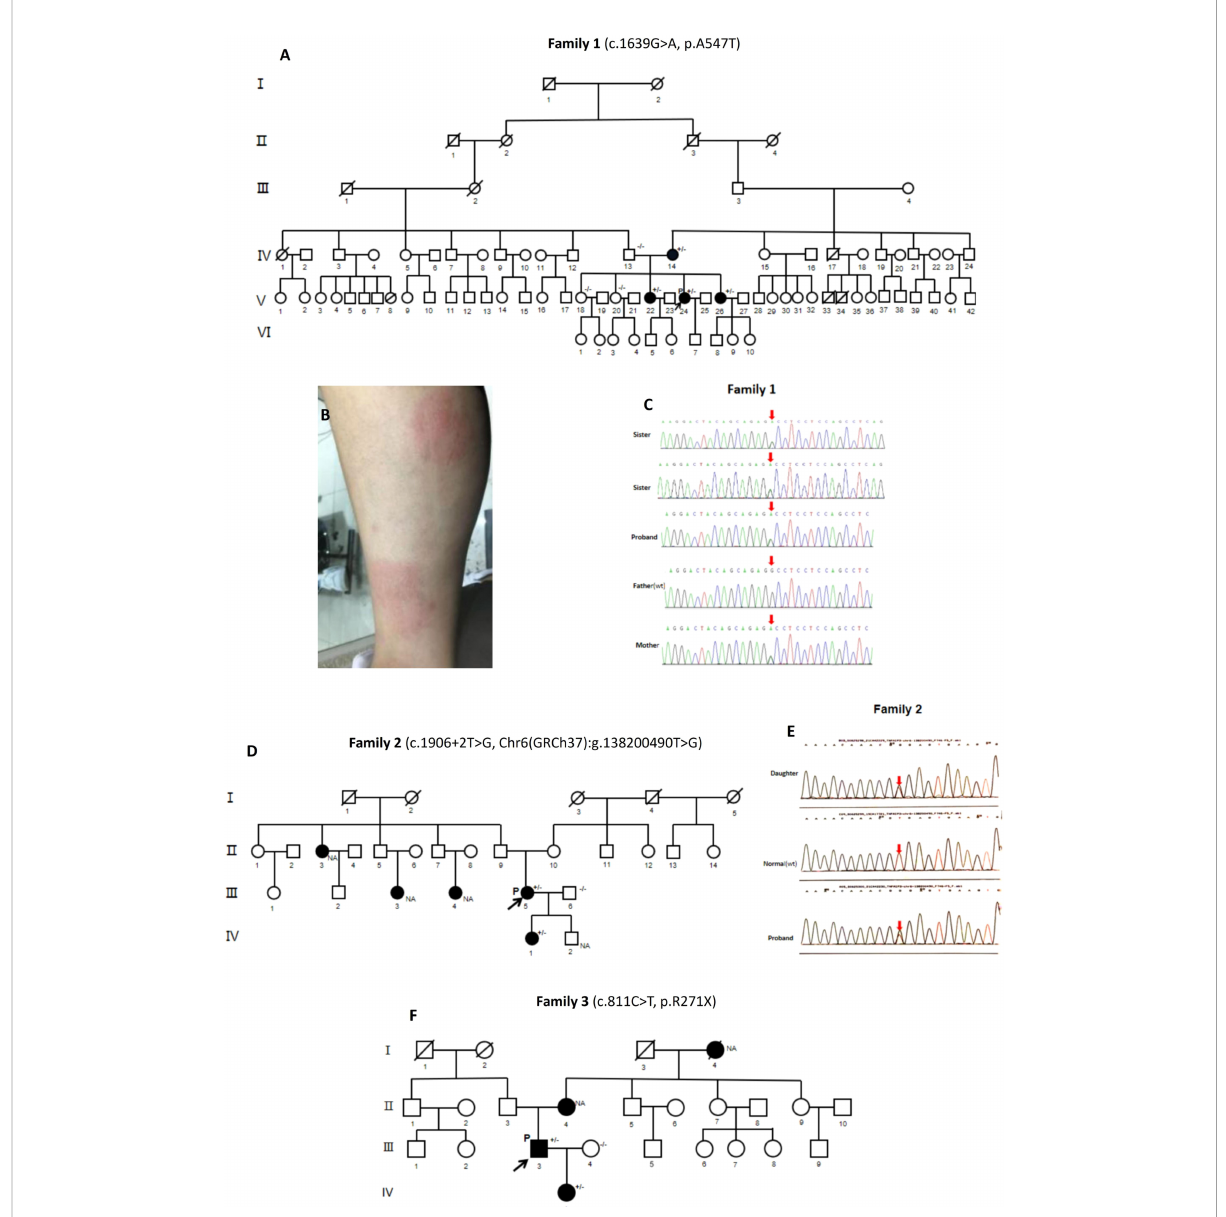
FIGURE 1 Family pedigrees, clinical manifestations, and gene sequencing of HA20 patients. (A) Pedigree analysis of Family 1. (B) Erythema nodosa of P1 (V.24). (C) Whole-exome sequencing by Next Generation Sequencing of Family 1, showing the heterozygous TNFAIP3 (NM_006290.4): c.1639G>A, p.A547T variant. (D) Pedigree analysis of Family 2. (E) Gene sequencing of Family 2, showing TNFAIP3 c.1906+2T>G heterozygous variant in P2 (III:5) and her daughter (IV:1). (F) Pedigree analysis of Family 3. P, proband; (+/-), Heterozygous variants; (-/-): Wild type; (NA),